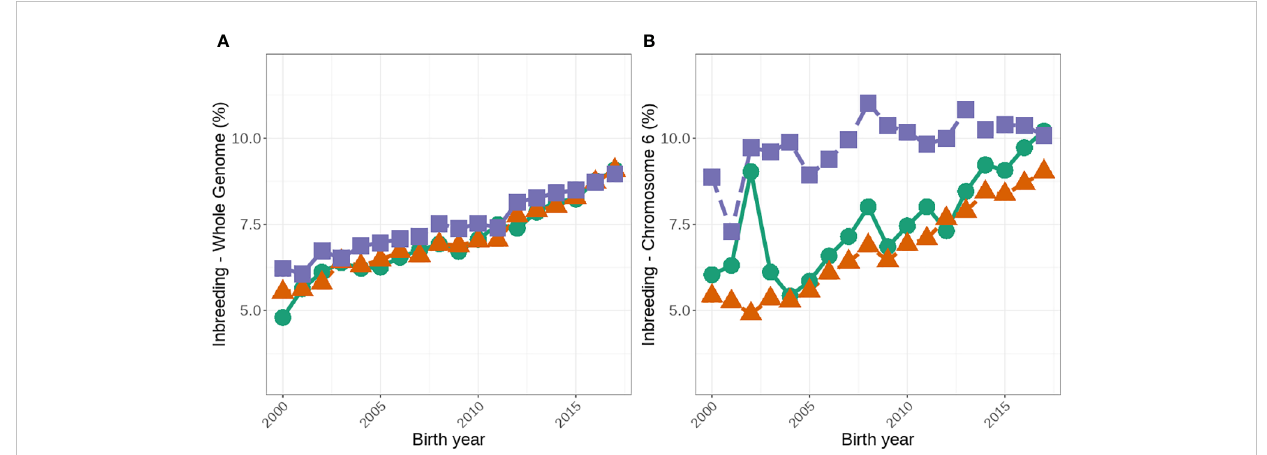
FIGURE 3 Average genomic inbreeding coef fi cients (%) for the whole genome (A) and on chromosome 6 (B) for females that are A1/A1, A1/A2 and A2/A2. The green lines with circles represent A1/A1, the orange lines with triangles represent A1/A2, and the purple lines with squares represent